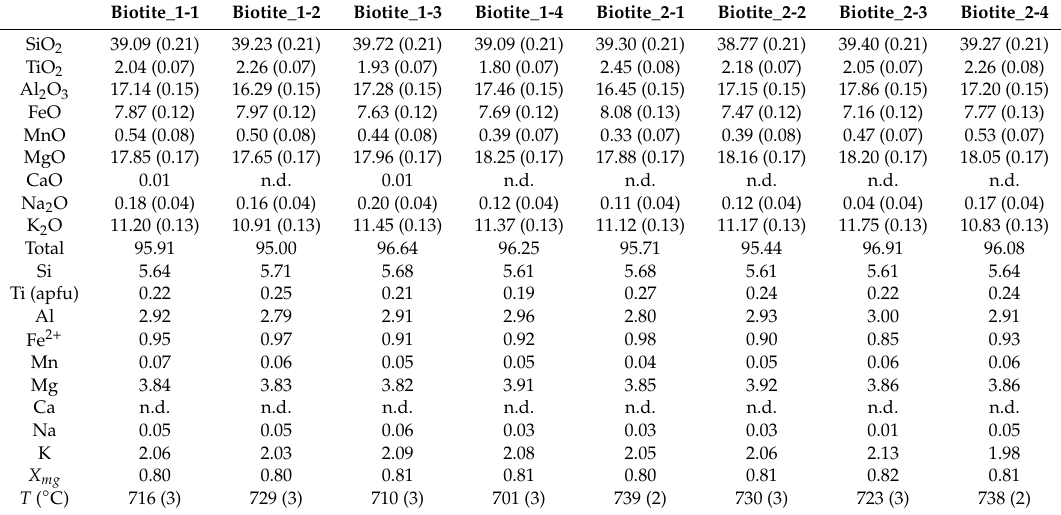
Table 2. Representative biotite compositions (wt%) used for Ti-in-biotite geothermometry [28]. Numbers in parentheses next to each analysis represent 1 σ and given in terms of least unit cited; n.d. = not